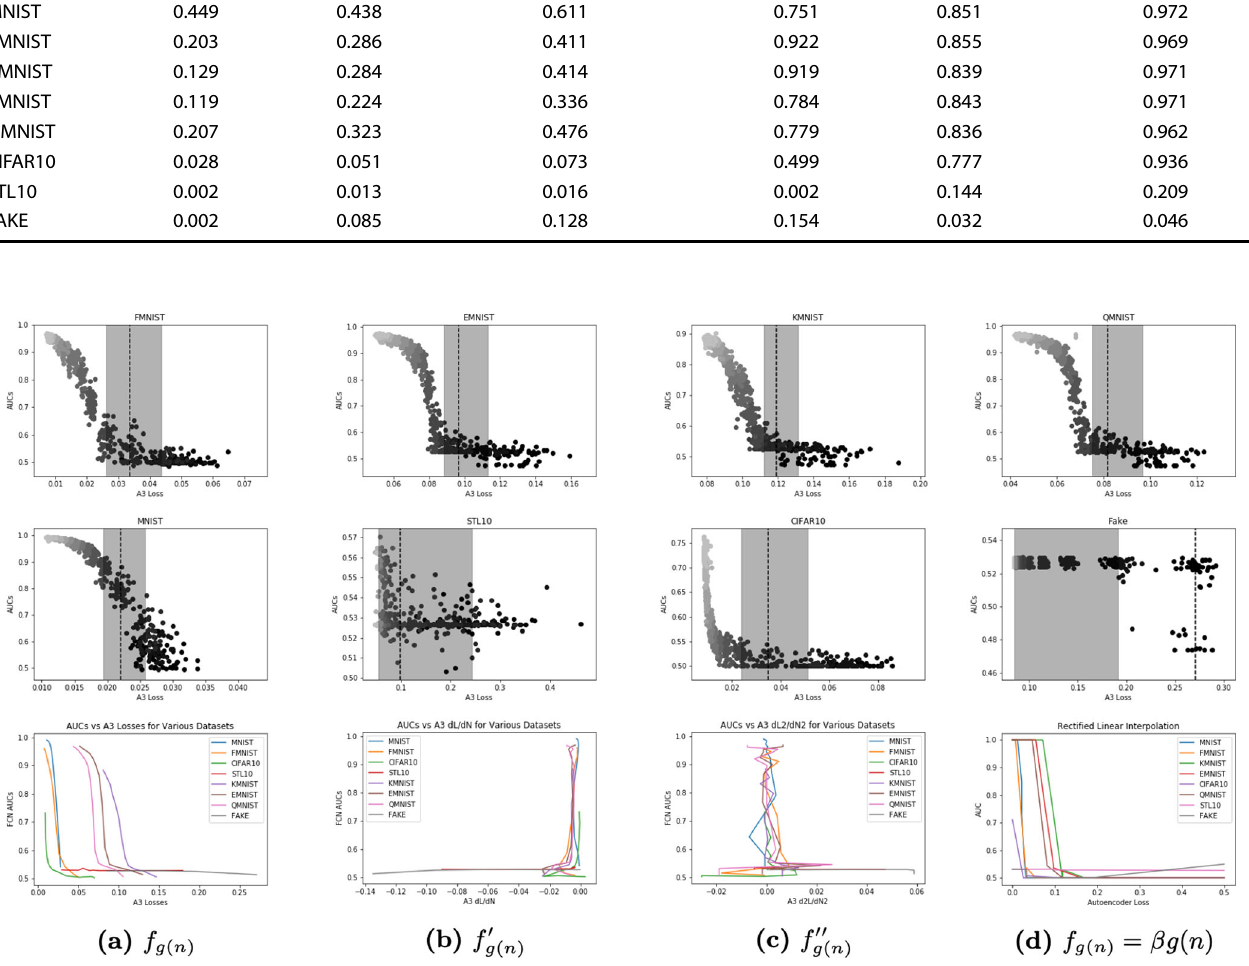
Fig. 3 Sample size estimation with in fl ection points. The top and middle rows are the results of individual datasets, while the bottom row is the combination of all eight tested datasets. The black striped line represents the autoencoder loss at the point of the in fl ection. The shaded region represents the error bars, with error determined as the autoencoder loss at ± ln(n), where n is the sample size at which the in fl ection point of the autoencoder loss occurs. The points are shaded by sample size. For each of these datasets, the autoencoder loss method appears to provide an unbiased estimate of the minimum convergence sample. The top row demonstrates appropriately sampled data while the middle row shows statistical power estimation on oversampled and undersampled data. The bottom row shows that linear interpolation